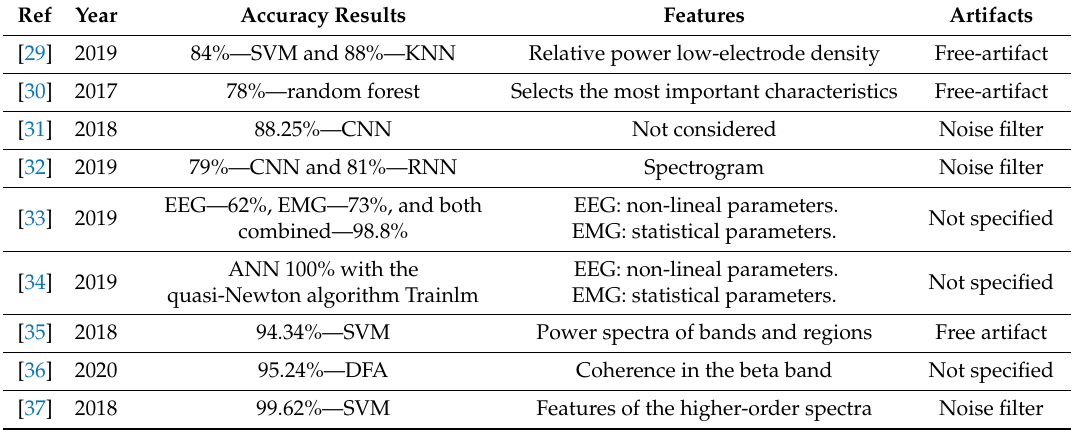
Table 4. Summary of the results, features introduced to the models and signal filtering shown in Tables 2 and 3 for the selected articles. The year of publication of each